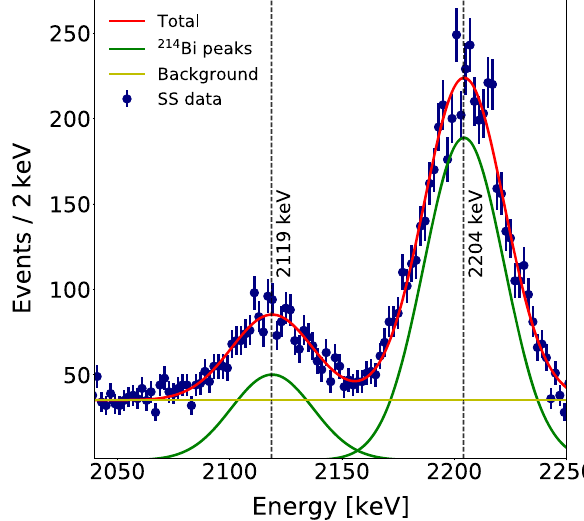
Fig. 7 Fit on the 214 Bi peaks above 2MeV, χ 2 / d.o.f = 113 . 7 / 118. The extracted value and standard deviation for the peak at higher energy are μ = 2204 . 4keV and σ = 17 . 9keV, respectively. The computed resolution is then σ/μ = 0 .